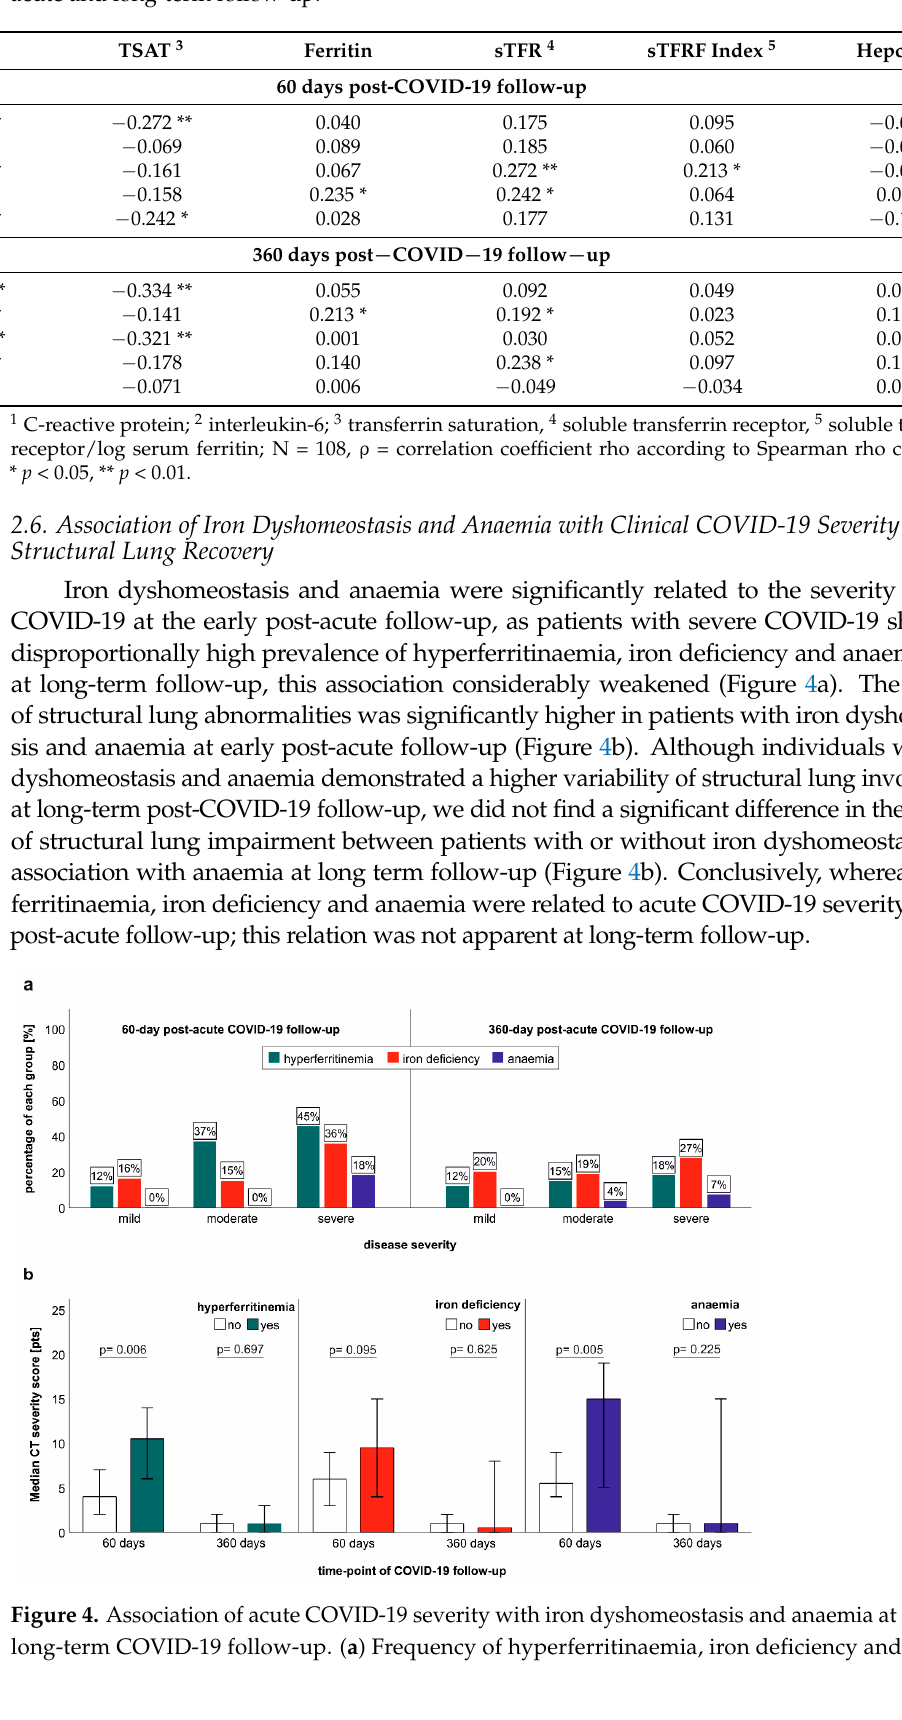
Table 4. Correlation of serum markers of thrombo-inflammation and iron parameters at early post- acute and long-term follow-up.